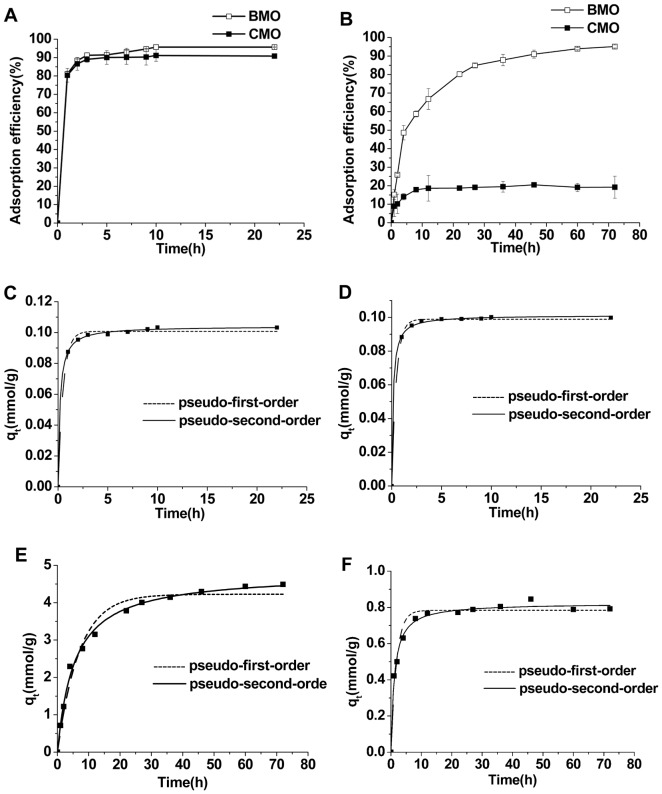
The Ag+ adsorption kinetics and fitting models.The adsorption kinetics of 0.5/L Ag+ (A) and 20 mmol/L Ag+ (B) by BMO (□) and CMO (▪). The pseudo-first order model and pseudo-second order model for adsorption of 0.5 mmol/L Ag+ by BMO (C) and CMO (D). The pseudo-first order model and pseudo-second-order model for adsorption of 20 mmol/L Ag+ by BMO (E) and CMO (F).